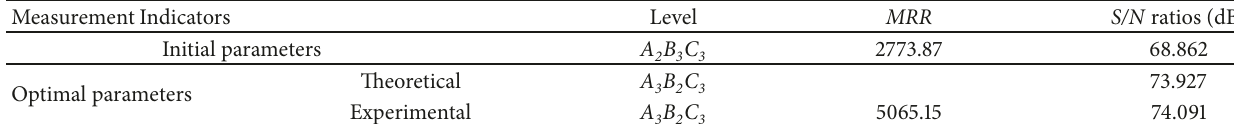
Table 8: Confirmation test results and comparison of S/N ratios.